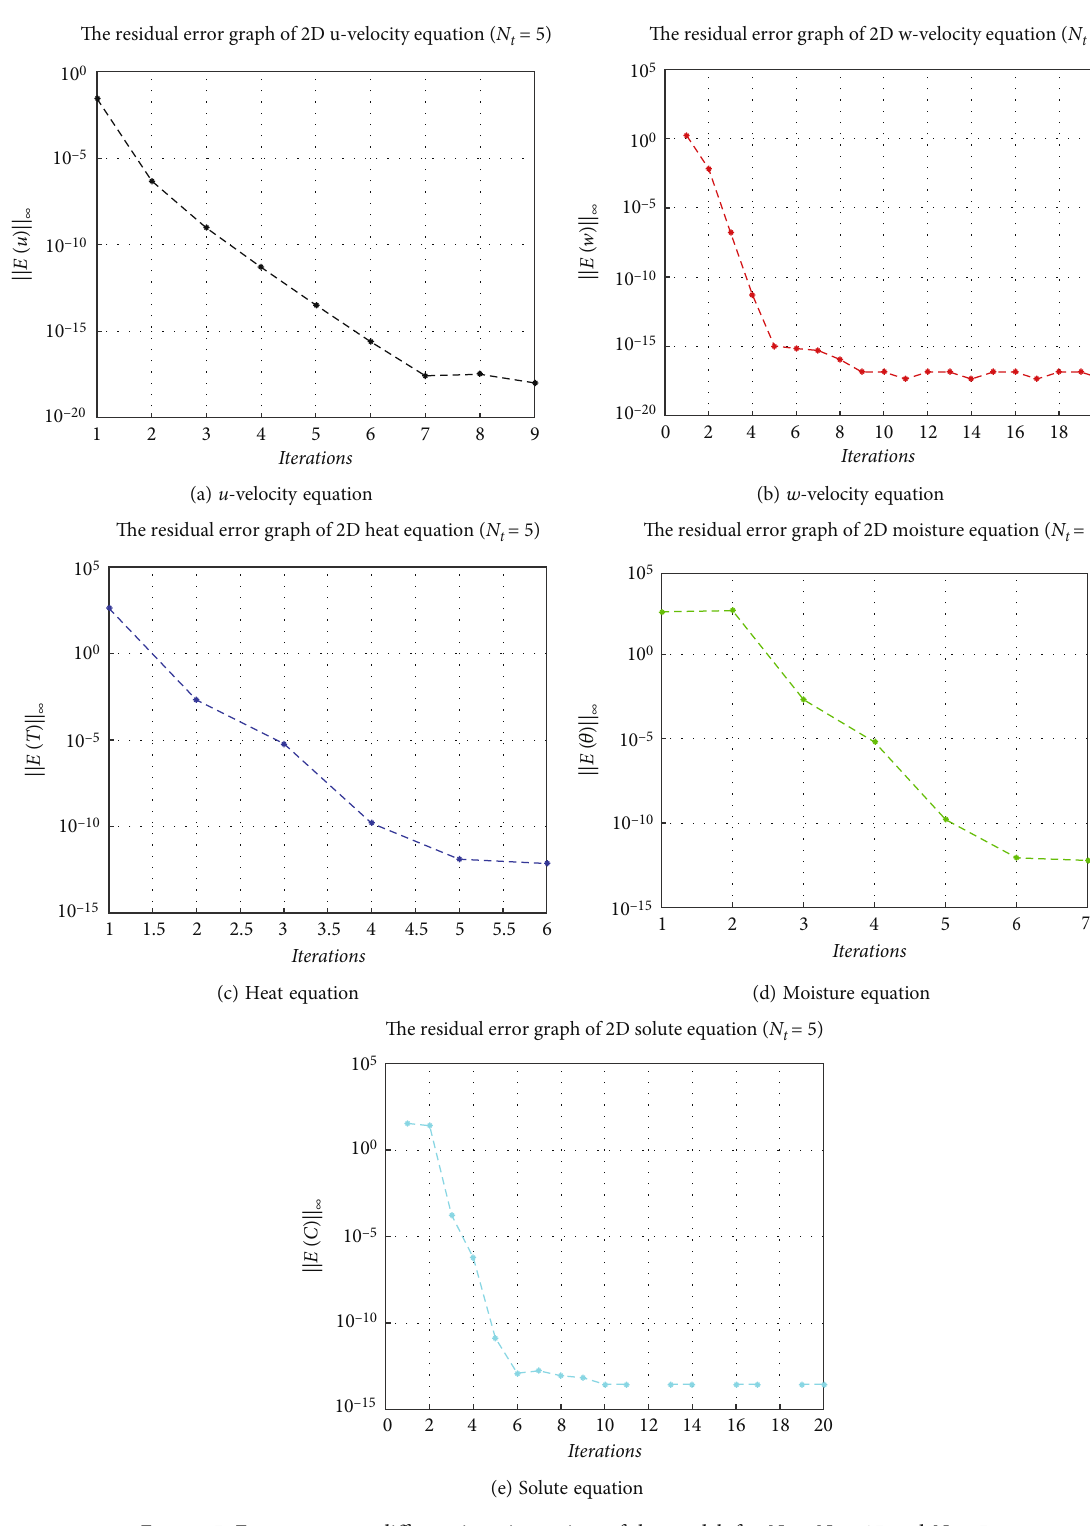
= N = 15 and N = 5 x z t